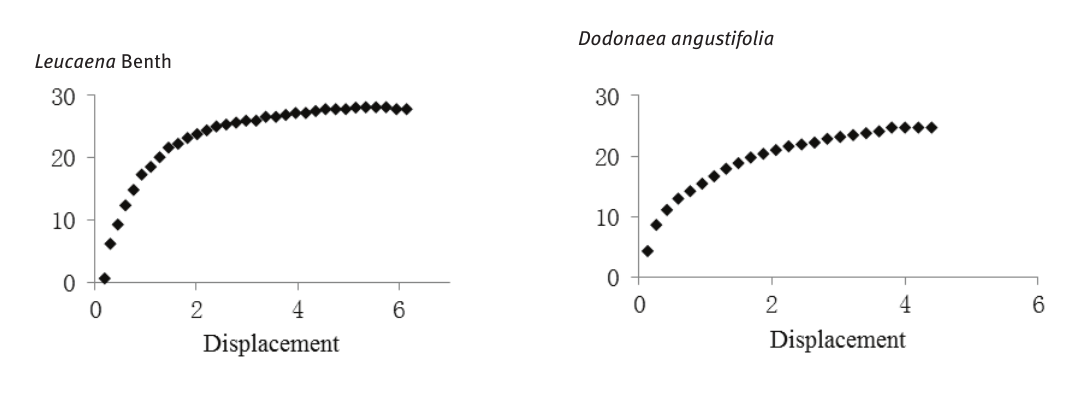
Figure 9: Relationship curve between shear strength increment and